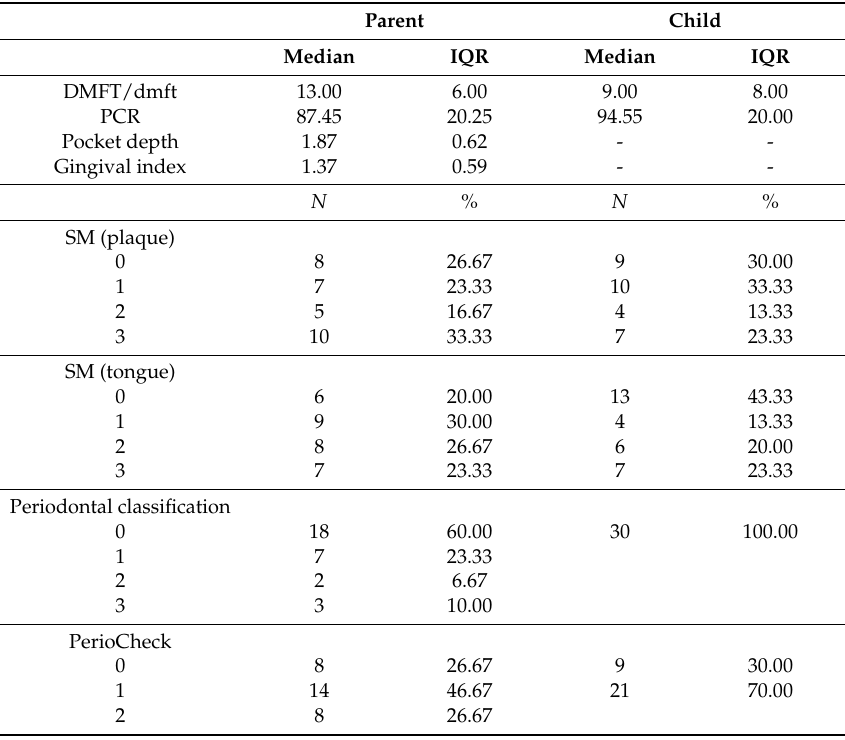
Table 2. Distribution of periodontal status and caries index scores in parent–child pairs.